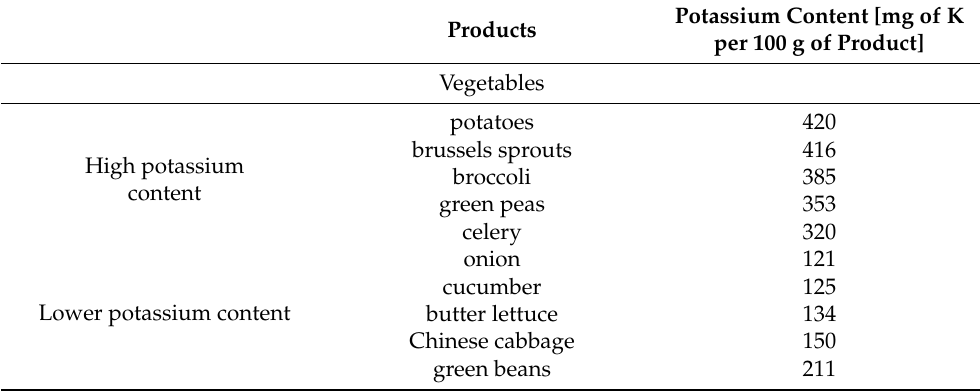
Table 2. Selected products with high and low potassium content